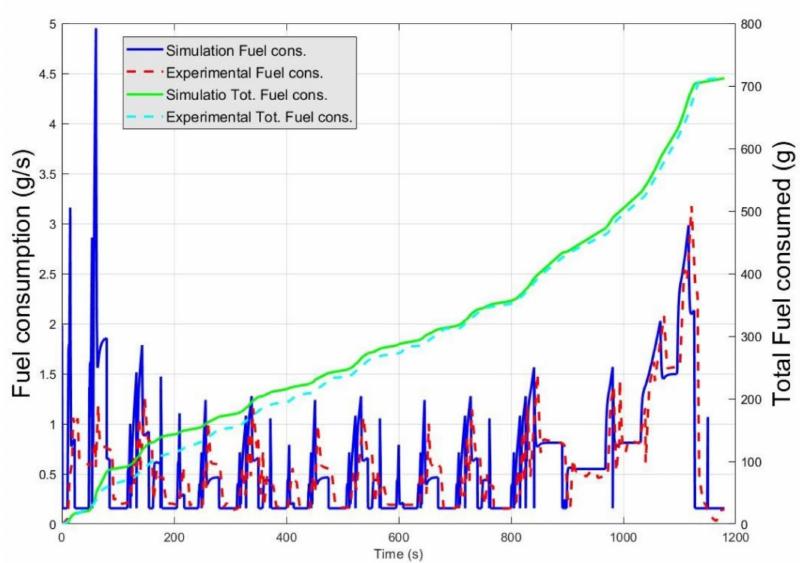
Figure 4. Fuel consumption in New European Driving Cycle (NEDC).